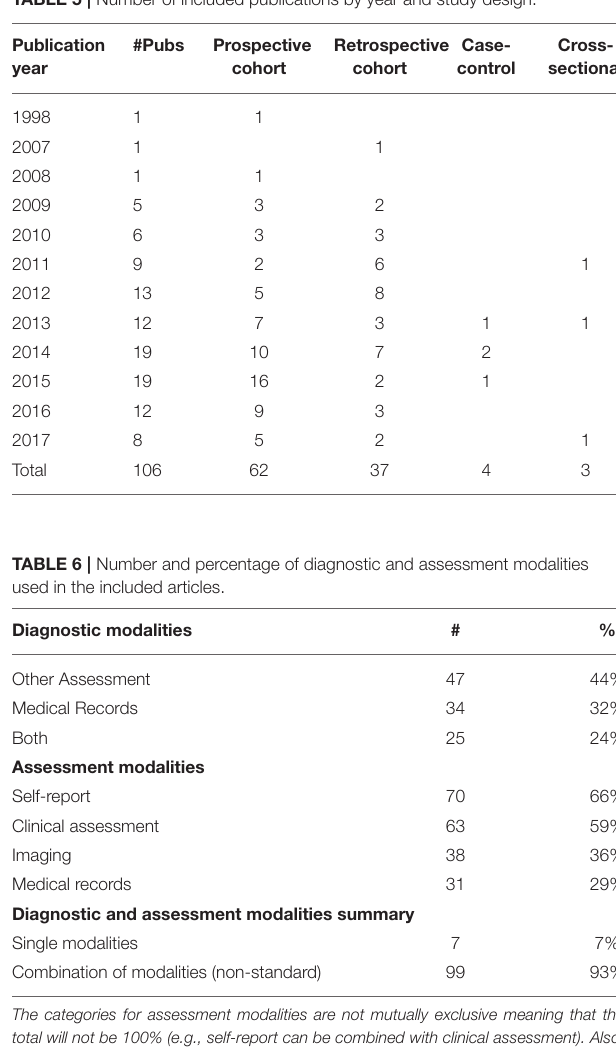
TABLE 7 | Data completeness in the included studies.